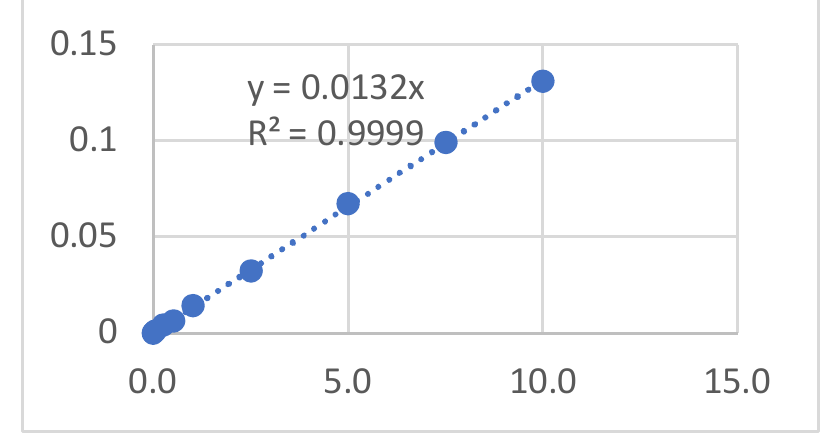
Figure 4. Fe calibration graphs.